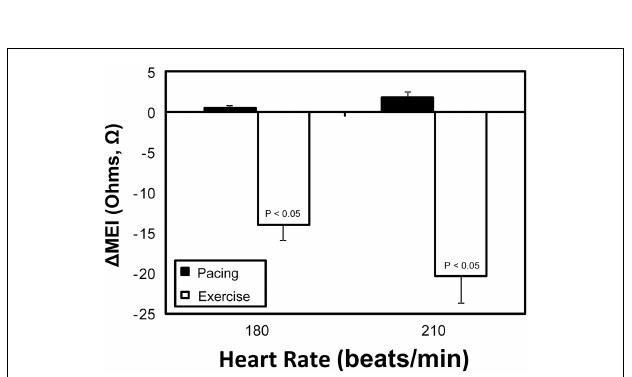
FIGURE 5 | Representative (top) and overall/mean (bottom) myocardial electrical impedance (MEI) response to direct β -adrenoceptor stimulation at rest (via escalating-dose infusion of isoproterenol), showing dose-dependent MEI decrease.